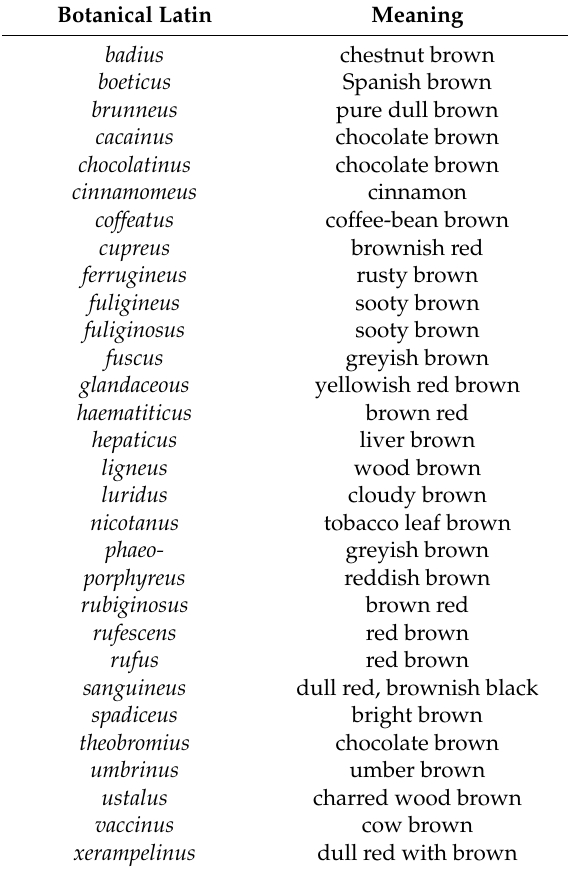
Table 3. Color terms for “brown” in botanical Latin